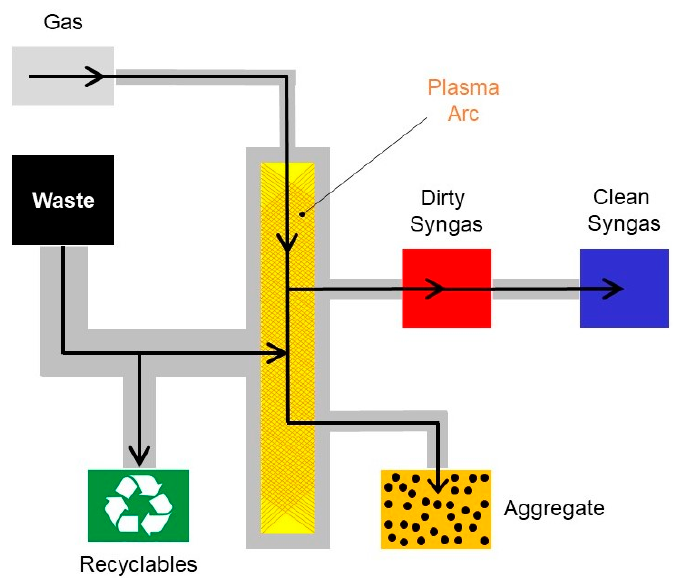
Figure 9. Solid waste treatment using plasma arc. Reproduced from reference [15] published under the license CC BY ‐ NC ‐ ND 4.0.